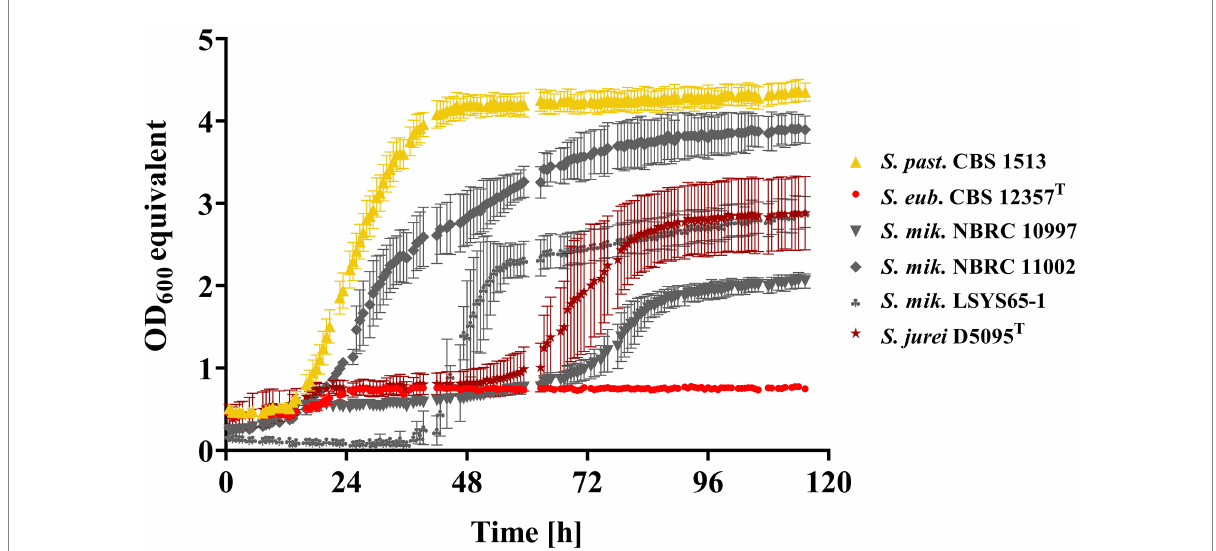
FIGURE 1 Growth kinetics in synthetic medium containing 2% (w/v) maltotriose (Mtt) of S. pastorianus CBS 1513 (Mtt + ; ▲ ), S. eubayanus CBS 12357 T (Mtt − ; ● ) and the non- S. cerevisiae maltotriose-positive candidates: S. jurei D5095 T ( ★ ), S. mik atae LSYS65-1 ( ♣ ), S. mik atae NBRC 11002 ( ♦ ) and S. mikatae NBRC 10997 ( ▼ ) recorded via Growth Profiler 1,152. Values are presented as mean and standard deviation of biological triplicates. Raw data are provided in Supplementary Table